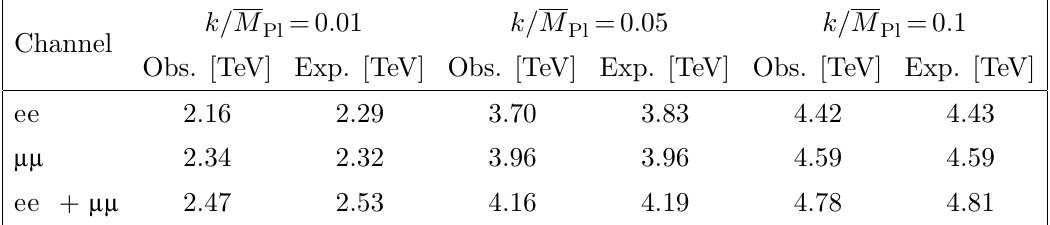
of 0.01, 0.05, Pl